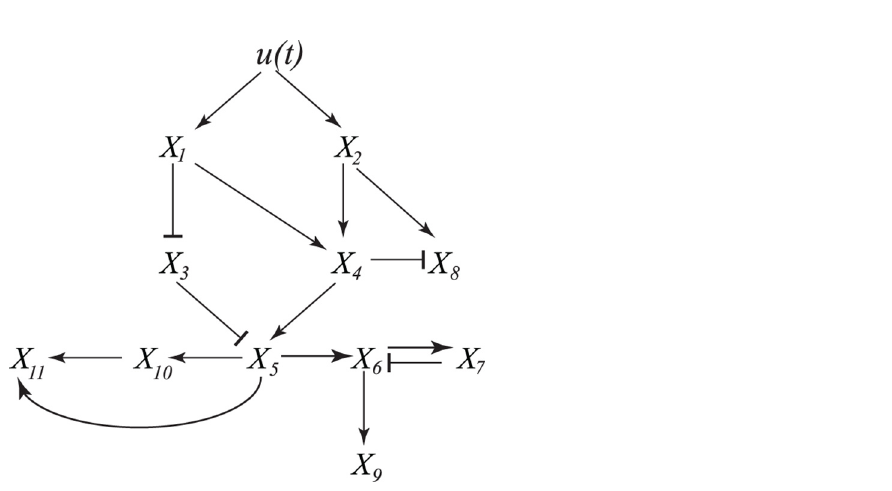
Fig 2. Sample graphical representation of a dynamical system to illustrate the theorem. The input node u(t) is a known input function. The dynamics of the dependent variables X i ( t ) are given by equations of the form of Eq 1. Arrows connect the nodes connect nodes with non-zero partial derivatives; pointed and blunt arrows correspond to positive and negative partial derivatives respectively (see text for details).